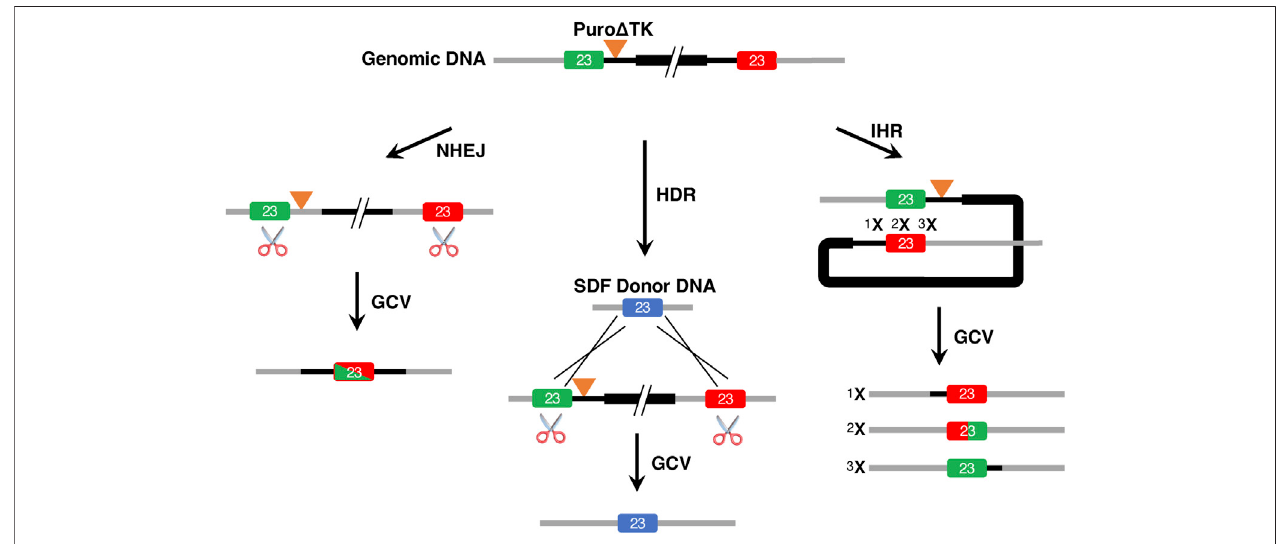
FIGURE 5 | Removal of Vector Insertions by NHEJ, HDR, and IHR. This illustrates the approaches used to generate single-copy exon 23 alleles from vector insertion event cell lines. For this fi gure the exon colors are used to indicate potential recombination products and do not necessarily represent different W1282X alleles.